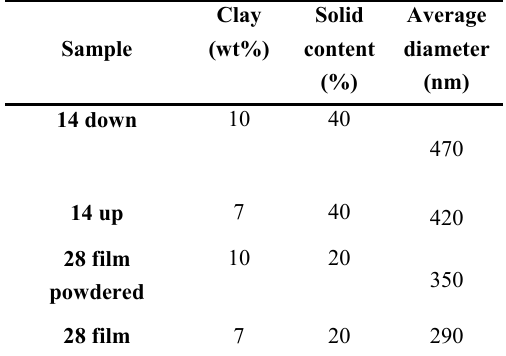
Table 2. Particle size measured by DLS analysis.